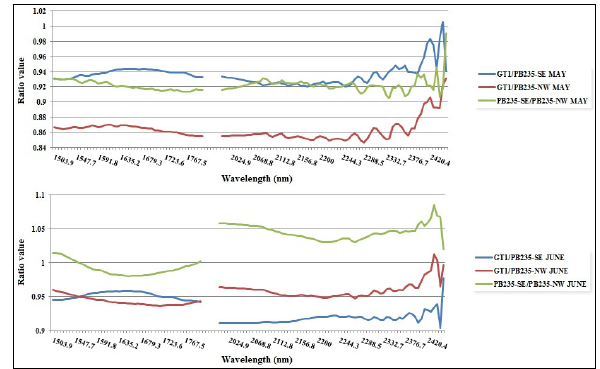
Figura 19. Ratios among spectra of the Rubber trees stands (GT1, PB235-SE and PB235-NW) from 1,300 to 2,500nm, for May and June, in canopy scale